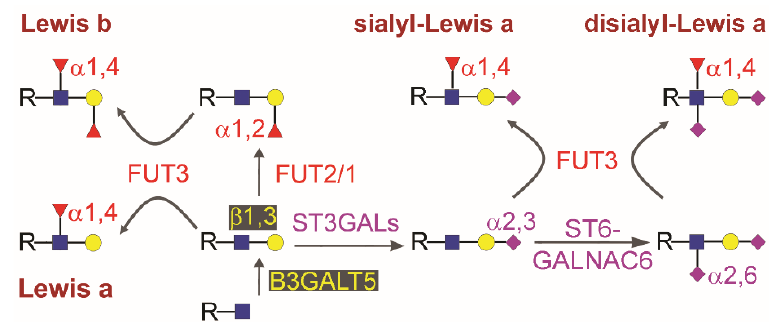
Figure 1. Structure of type 1 chain Lewis antigens and biosynthesis in gastrointestinal tissues. Monosaccharides are depicted according to the current representation: Blue square, GlcNAc, N-acetylglucosamine; yellow circle, Gal, galactose; Red triangle, Fuc, fucose; Pink diamond, sialic acid, Sia. Anomers, linkage positions, and enzymes involved in the reactions are indicated. Glycosyltransferases are named according to the HUGO recommendations. Note that B3GALT5 activity is necessary giving rise to the Gal β 1,3GlcNAc-R sequence that is the common precursor of all the antigens, as is FUT3 activity, since the presence of a Fuc α 1,4 linked to GlcNAc is mandatory for antibody recognition.